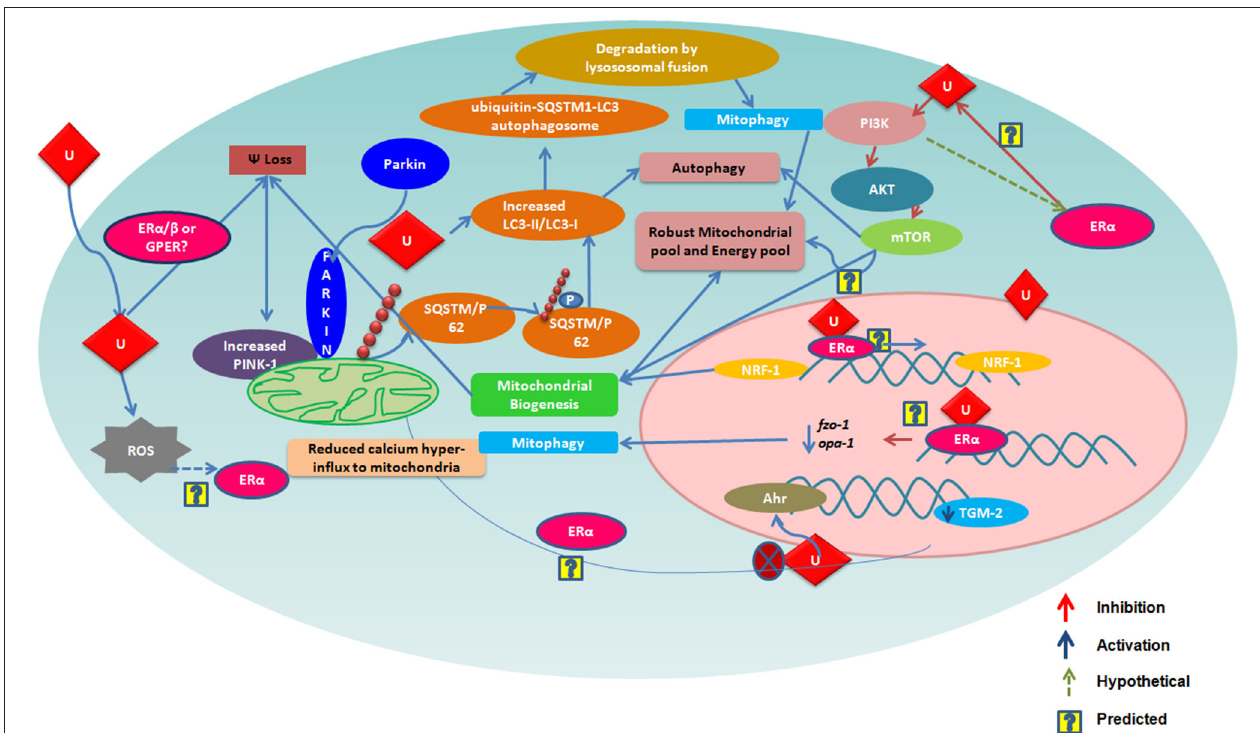
pool maintaining a healthy pool of